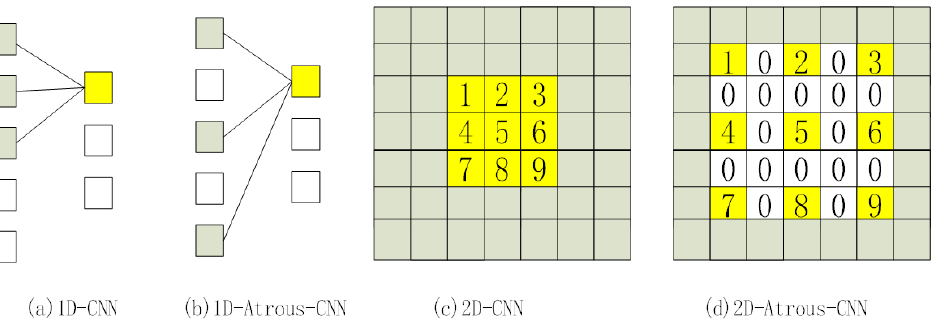
Figure 7. Standard Convolution and Hole